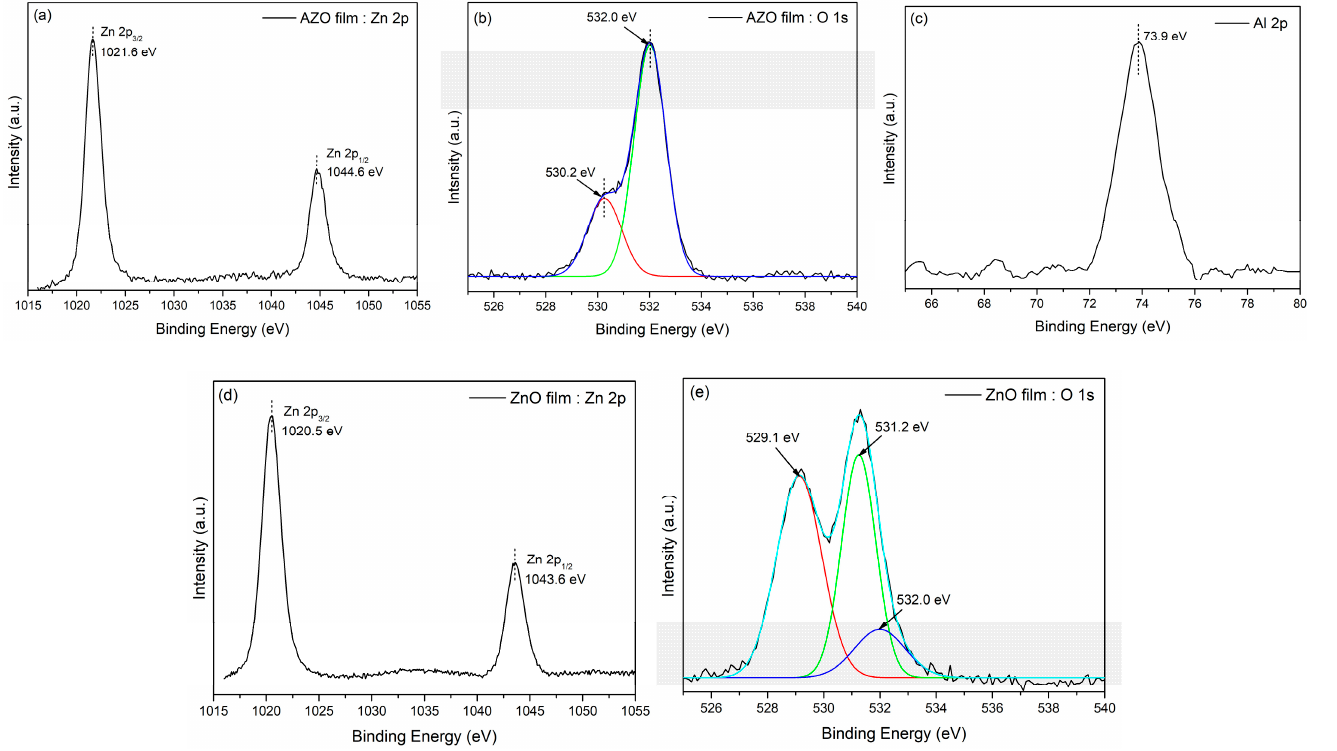
Figure 4. The XPS spectral analysis of sensing films includes ( a ) Zn 2p, ( b ) O 1s, and ( c ) Al 2p spectra of the AZO film and ( d ) Zn 2p and ( e ) O 1s spectra of the ZnO film. Table 3. The potential of the ENIG in pH 2 to 10 buffer